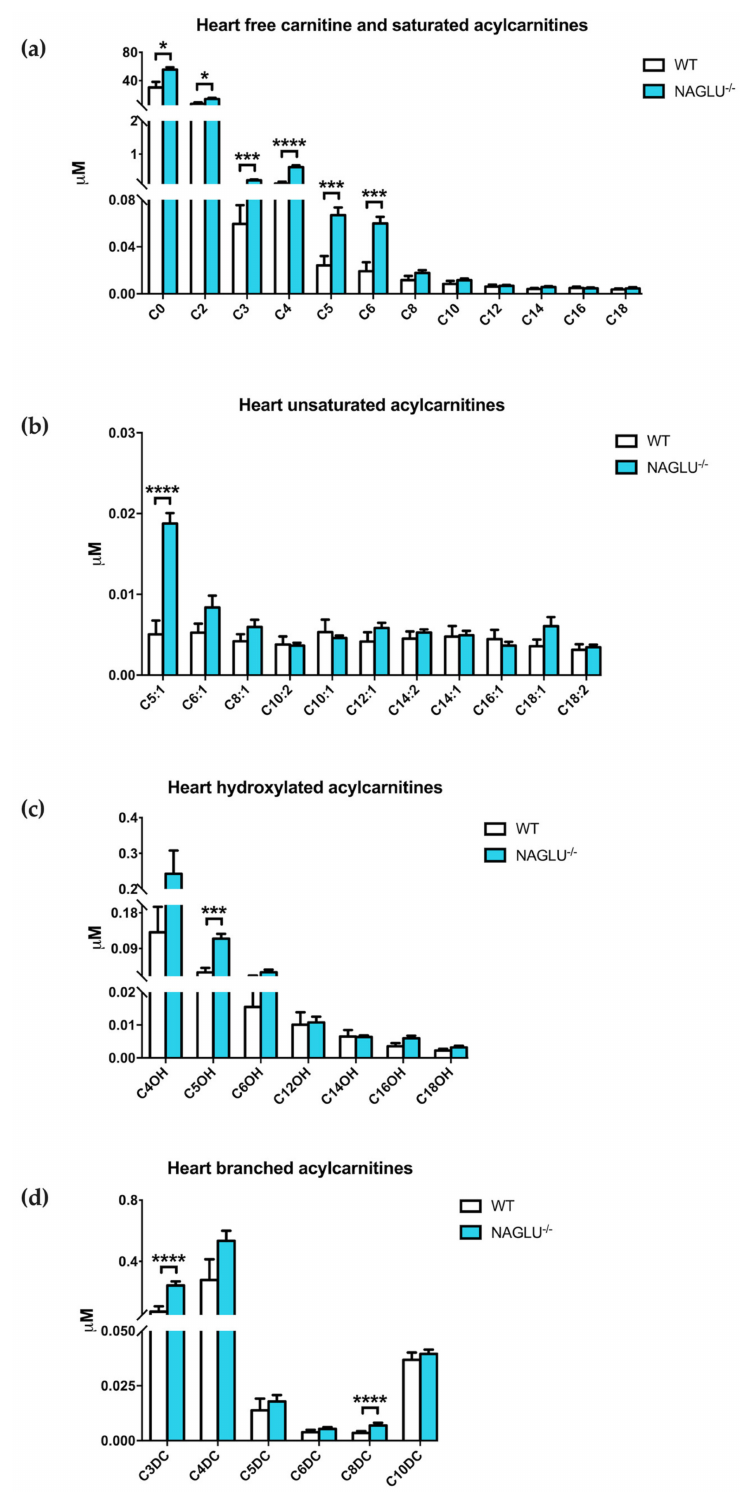
Figure 6. Heart-specific accumulated acylcarnitines in NAGLU − / − mice: free carnitine and saturated acylcarnitine ( a ), unsaturated acylcarnitine ( b ), hydroxylated acylcarnitine ( c ) and branched acylcarnitine ( d ). Results are represented as the mean ± standard error of the mean (SEM). The statistical significance of the di ff erence in metabolite tissue concentrations between genotype conditions (NAGLU − / − and WT) was evaluated by parametric or non-parametric tests when data failed the Shapiro–Wilk normality test. * p < 0.05, *** p < 0.001, **** p <